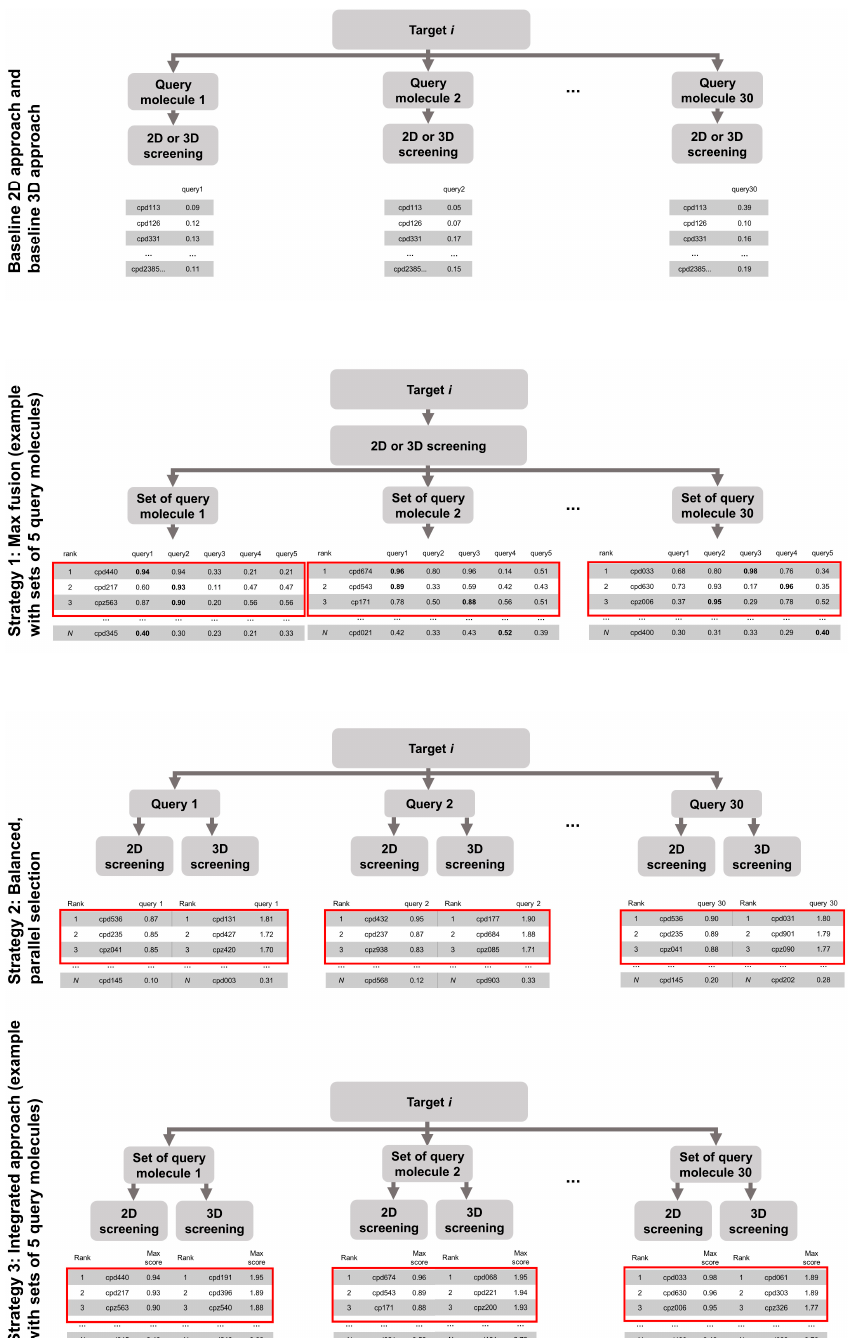
Figure 1. Overview of the investigated virtual screening approaches and strategies. The red boxes highlight the compounds selected by the individual hit selection strategies. highlight the compounds selected by the individual hit selection